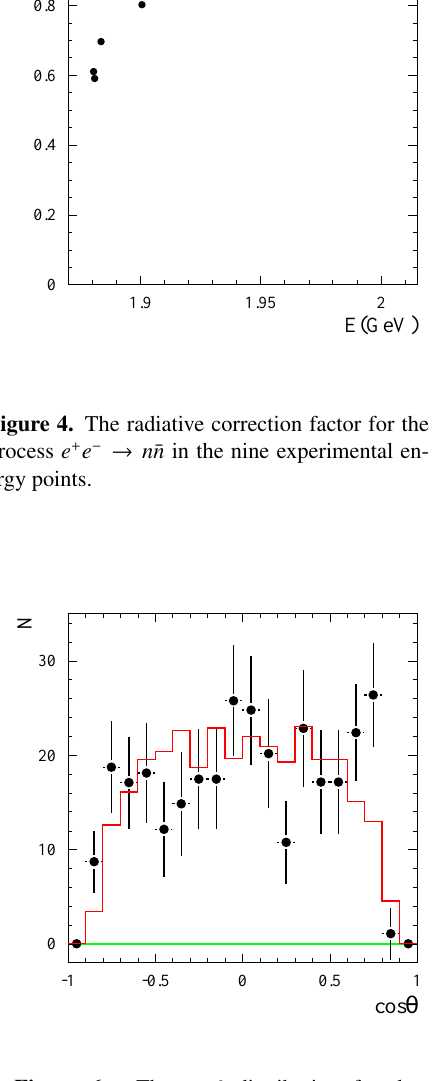
Figure 5. The e + e − → n ¯ n cross section mea- sured in this work compared with the previous measurements [1, 2]. The vertical line shows the n ¯ n threshold.